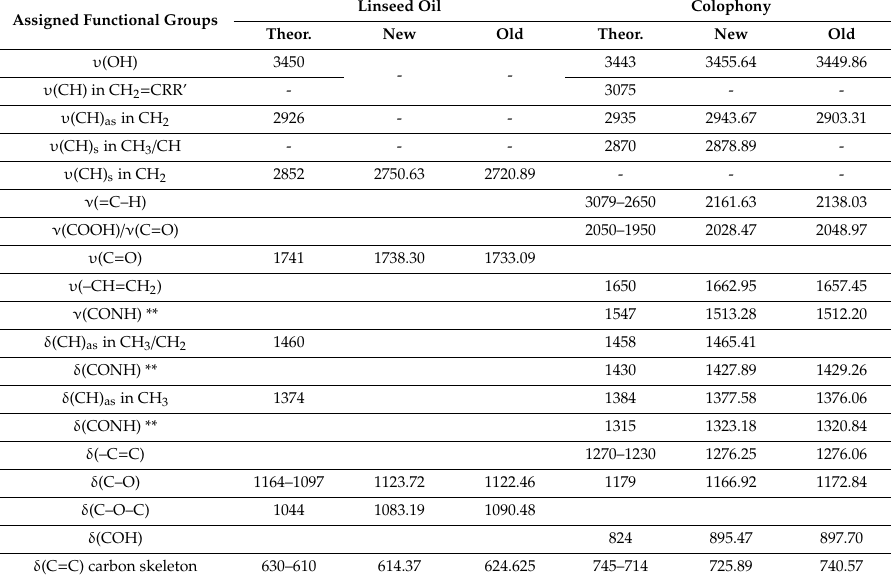
Table 1. IR bands for linseed oil and colophony (in cm − 1 ). Assigned Functional